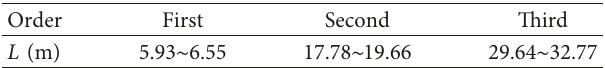
Figure 5: The pressure pulsation of ① : (a) pressure-time curve; (b) frequency spectrum. Table 1: The first three resonant piping length “ L ” of the inlet